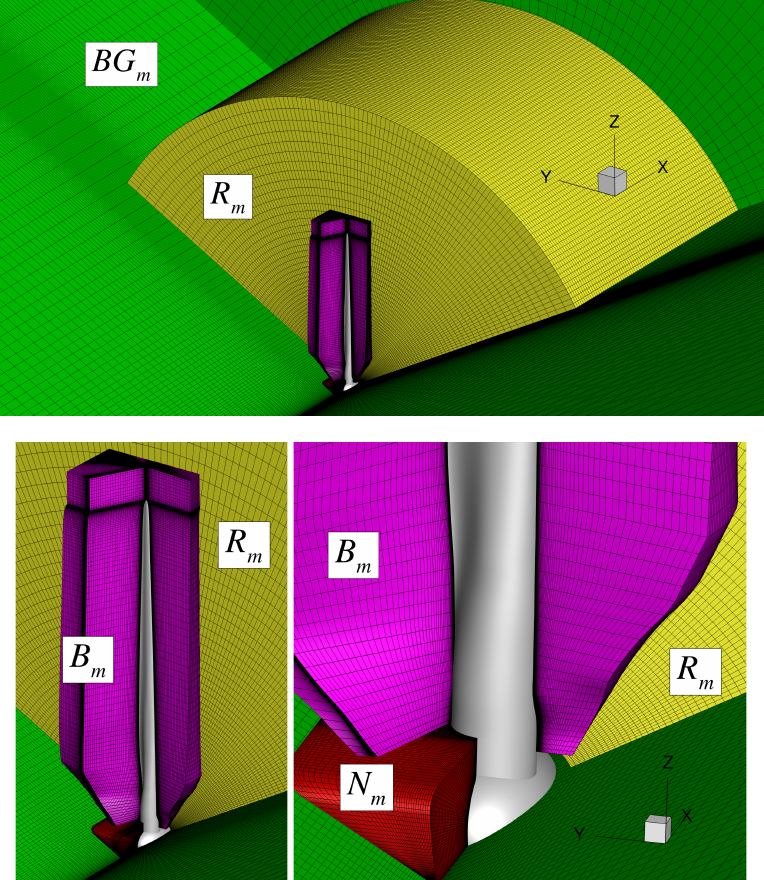
Figure 6. Grid setup showing blade (purple); spinner and nacelle (red); refinement (yellow) and background grids (green). Variables X , Y and Z represent coordinate system in the inertial frame of